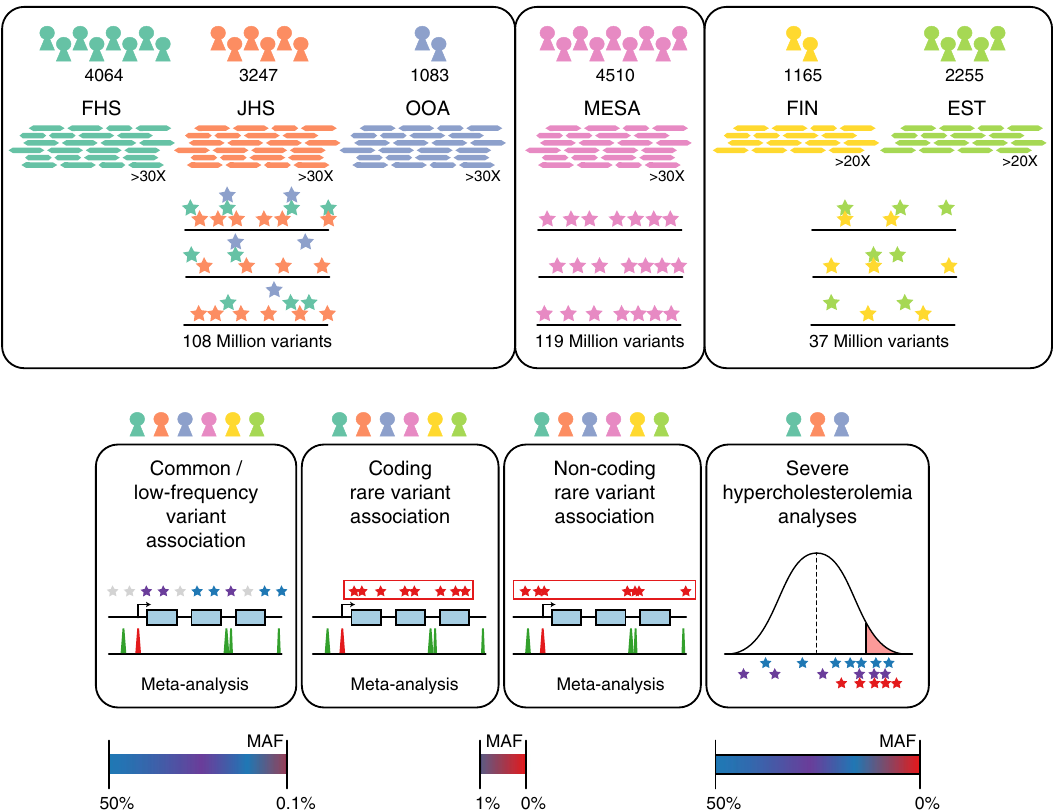
Fig. 1 Schematic of genomic variant discovery and analyses. Variants were jointly discovered in three distinct sets: (1) FHS, JHS, and OOA; (2) MESA; and (3) EST and FIN. Cohorts included in analyses are denoted by color-coded icons. Allele frequency spaces assessed are indicated for analyses. EST